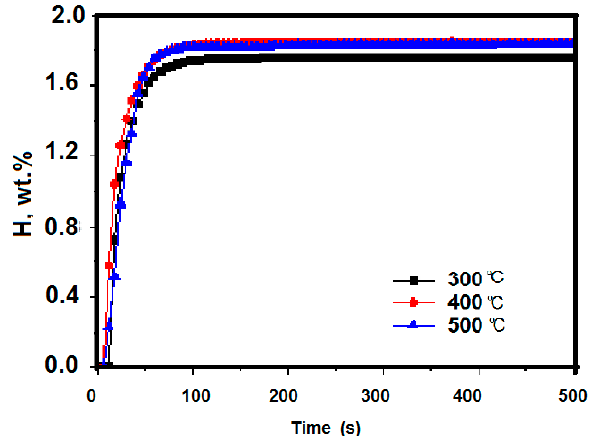
Figure 2. Kinetics of hydrogen absorption at 0.1 MPa after 3 h activation at different temperatures.